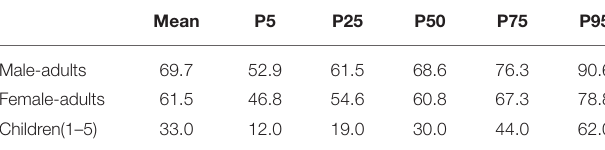
TABLE 2 | Body weight distribution (kg) (East China, China,